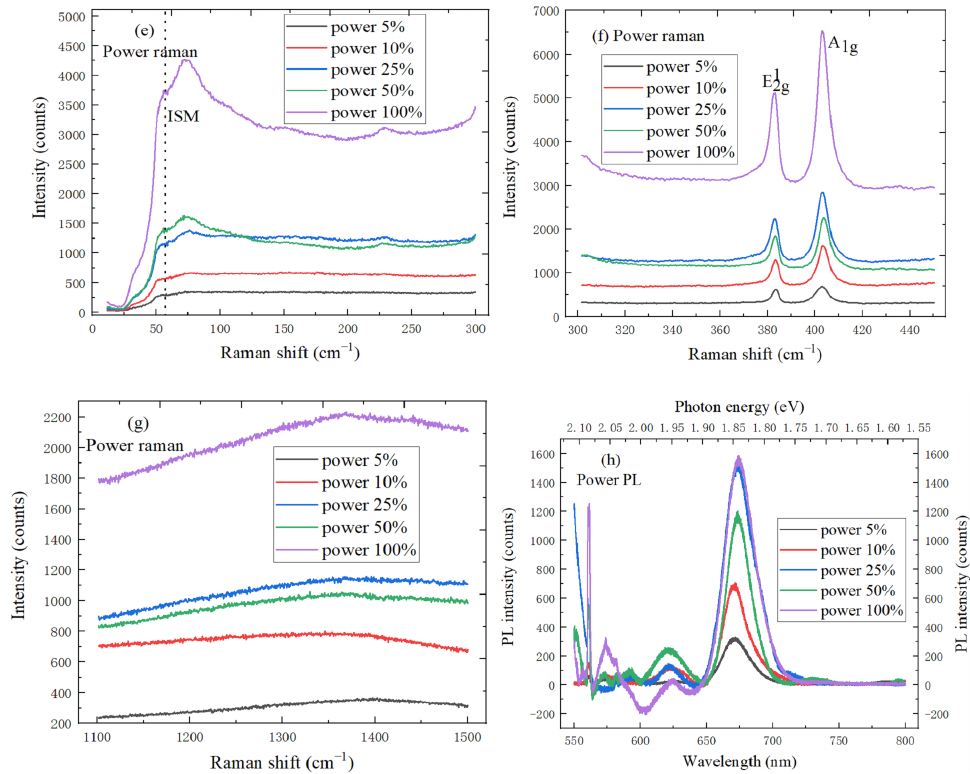
Figure 7. Spectral characteristics of MoS 2 / h-BN heterostructure. ( a ) ISM mode peak of h-BN at three different test points; ( b ) Raman peak of MoS 2 at three different test points; ( c ) IPM mode peak of h-BN at three different test points; ( d ) PL spectrum of MoS 2 /h-BN heterostructure at three different test points; ( e ) ISM power mode peak of h-BN; ( f ) power Raman peak of MoS 2 ; ( g ) IPM power mode peak of h-BN; ( h ) power PL spectrum of MoS 2 /h-BN heterostructure.